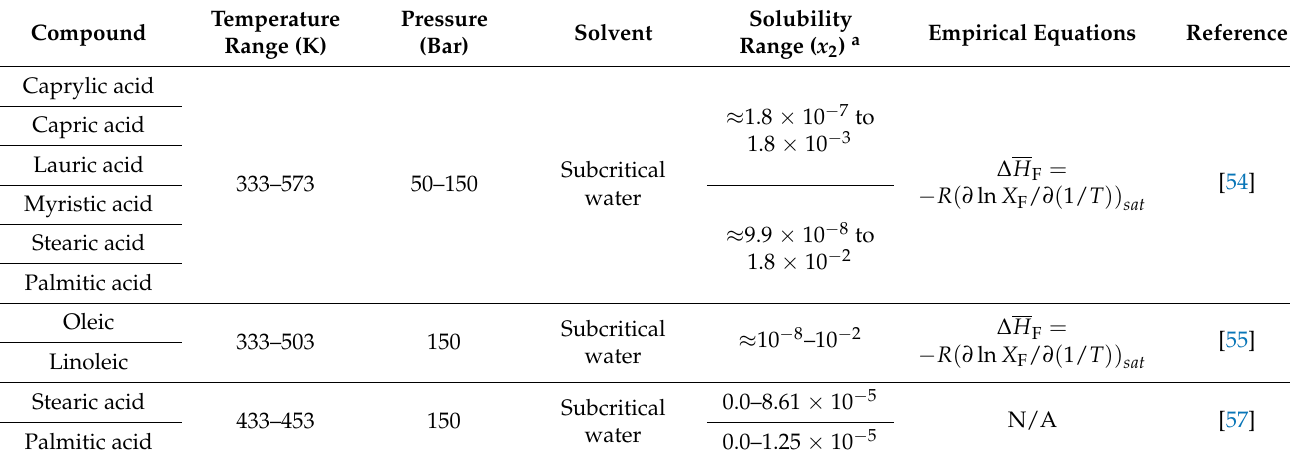
Table 6. Fatty acid solubilities in subcritical